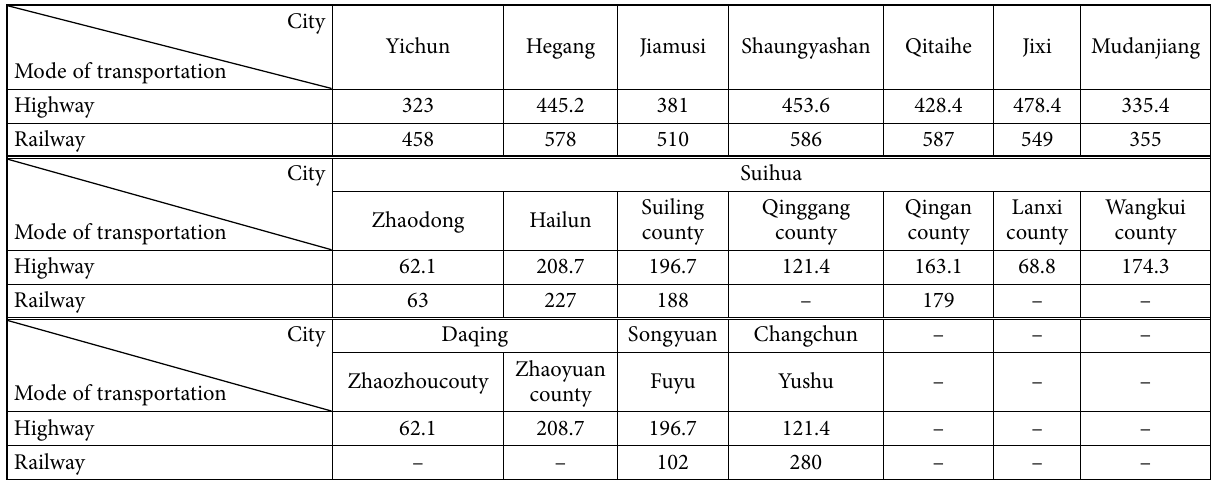
Table A3. The railway and highway distance from each city in attraction area to Harbin